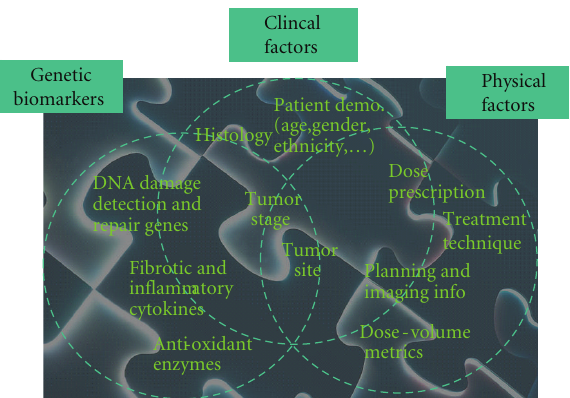
Figure 2: Radiotherapy treatment involves complex interaction of physical, biological, and clinical factors. The successful datamining approach should be able to resolve this interaction “puzzle” in the observed treatment outcome (e.g., radiation-induced lung injury) for each individual